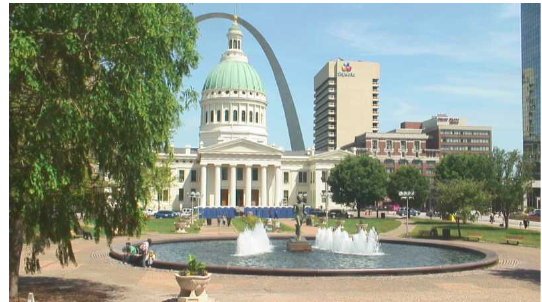
Figure 11. Sample property prediction results and the ground truth. (Predicted values, ground truth)s of temperature, humidity, visibility, and wind speed are: (11 ◦ C, 12 ◦ C), (42%, 39%), (10 miles, 10 miles), and (13 miles/h, 11 miles/h),